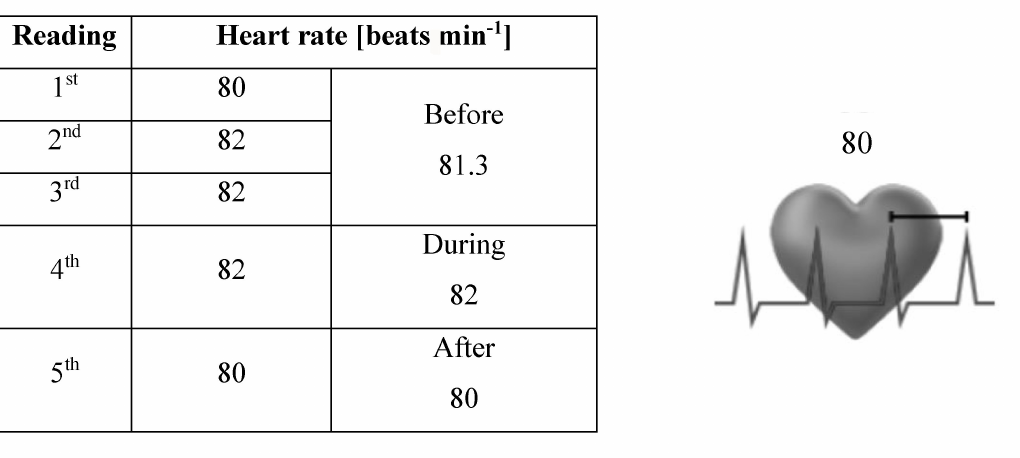
Fig. 2. Heart rate of a golfer retrieved by InPutter while putting. The different colours/intensities in the table are simply used to easily identify each phase, before, during and after putting, in accordance to the same colours/intensities used later